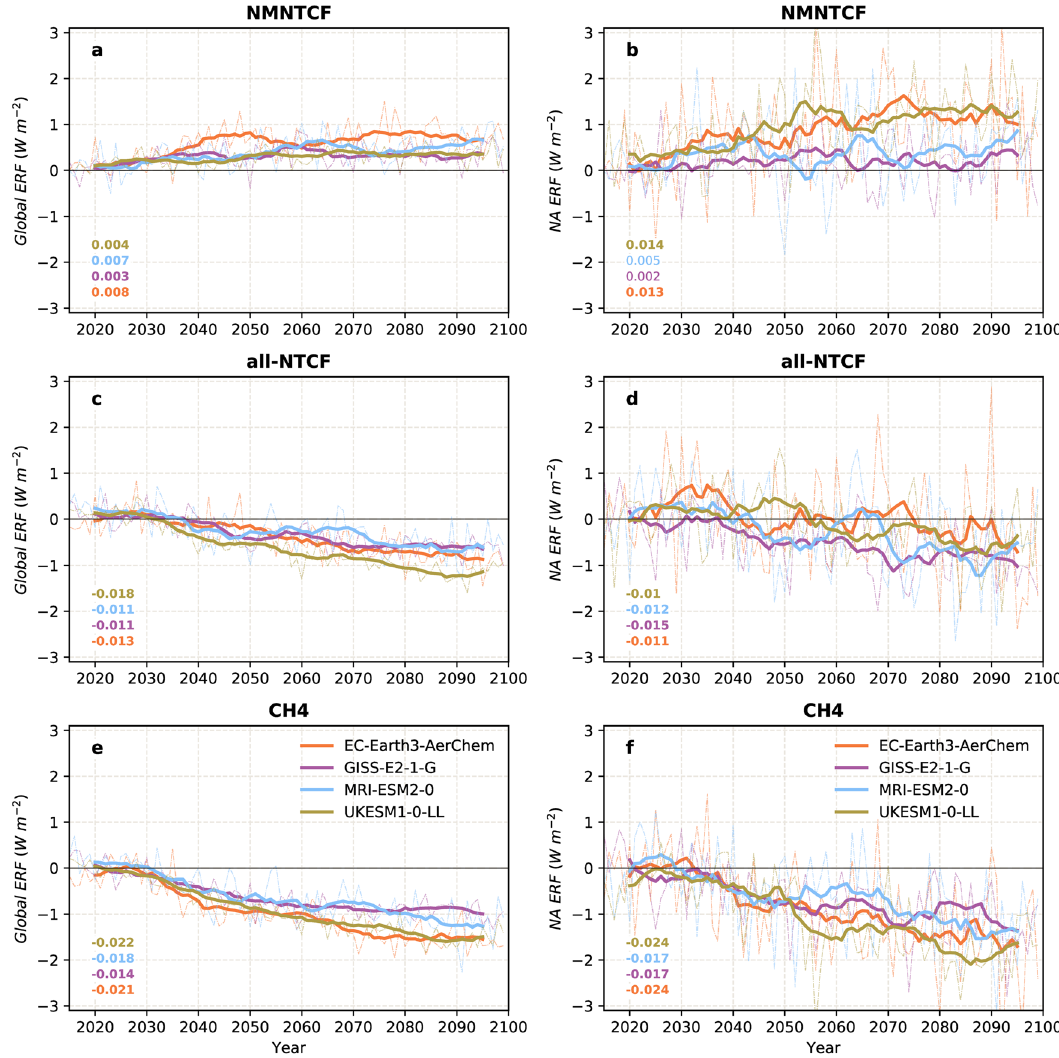
Fig. 3 2015 – 2100 effective radiative forcing for the three mitigation signals. a , c , e Global and b , d , f North Atlantic annual mean effective radiative forcing (ERF; W m − 2 ) time series for each model for a , b NMNTCF, c , d all-NTCF, and e , f CH 4 mitigation. Thick lines show the smoothed time series using a 10-year running mean. Also included is the slope of the least-squares trend line (units of W m − 2 year − 1 ), color coded by model as de fi ned in the legend. Bold trends are signi fi cant at the 95% con fi dence level, based on a standard t